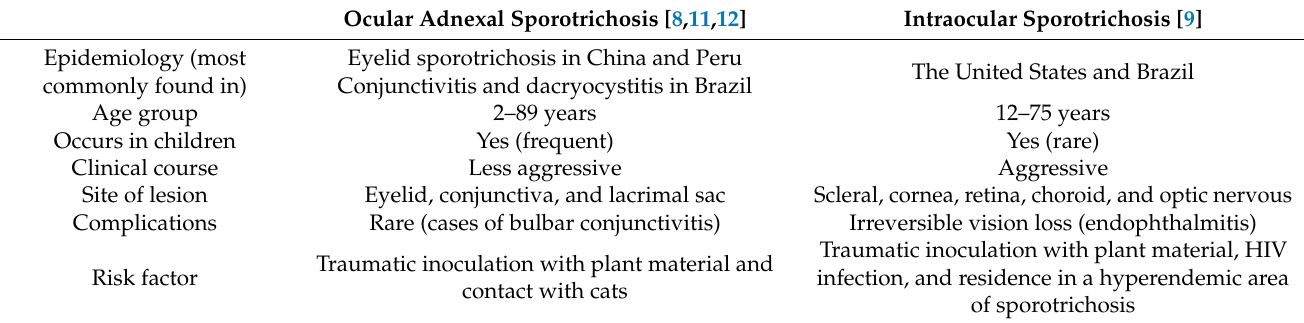
Figure 3. Clinical types of lesions observed in patients with ocular sporotrichosis. ( A , B ) Lymphocu- taneous eyelid sporotrichosis is characterized by the emergence of an indurated papule and nodules contiguous to the initial lesion. ( C – E ) Fixed sporotrichosis in upper eyelid. ( F ) Fixed sporotrichosis; granuloma-like plaque in upper eyelid. ( G ) Granulomas in the lower right palpebral conjunctiva (Courtesy of Isabella D. Ferreira-Gremião, Fiocruz, Rio de Janeiro, Brazil). ( H ) Dacryocystitis in the left eye. Table 1. Comparison between ocular adnexa infections and intraocular infection due to Sporothrix.